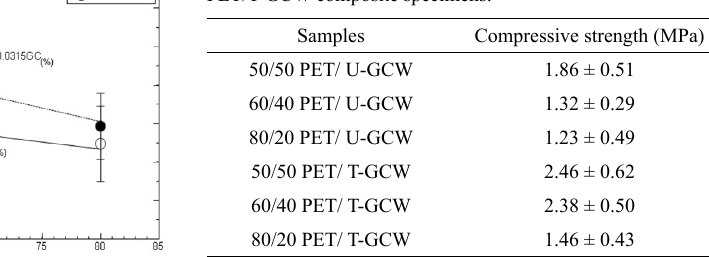
Table 7. Values of the compression test of the PET/U-GCW and PET/T-GCW composite